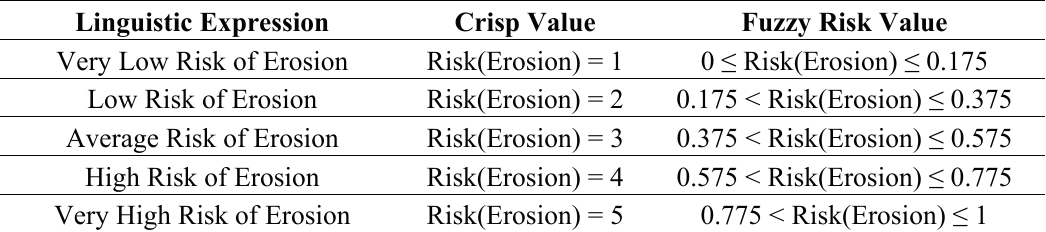
Table 3. Defuzzification results for final erosion risk